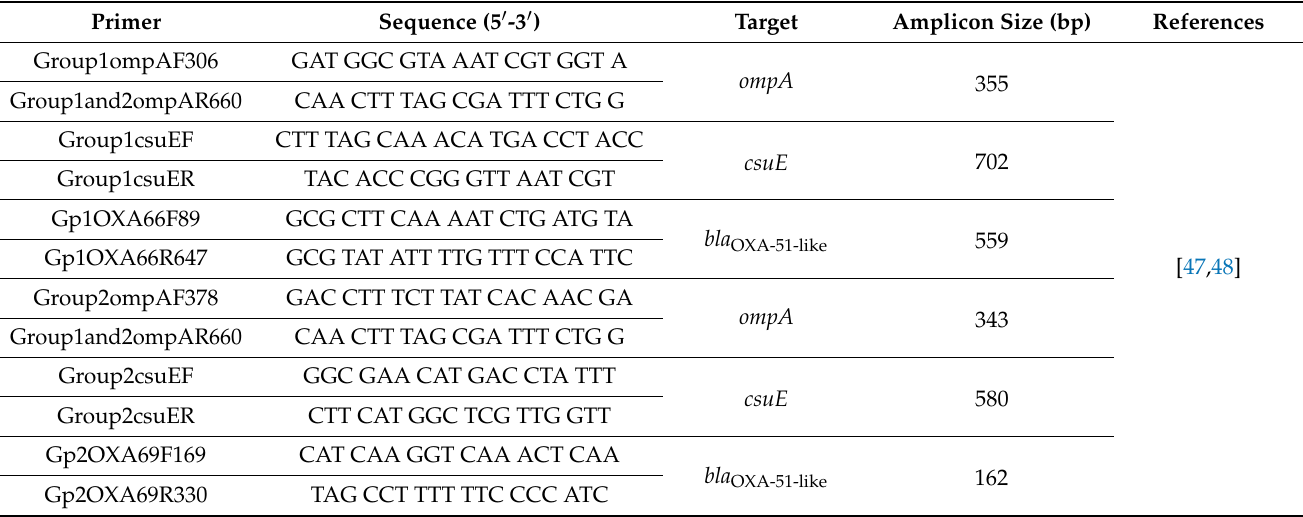
Table 3. Primers used in multiplex PCRs for identification of international clonal